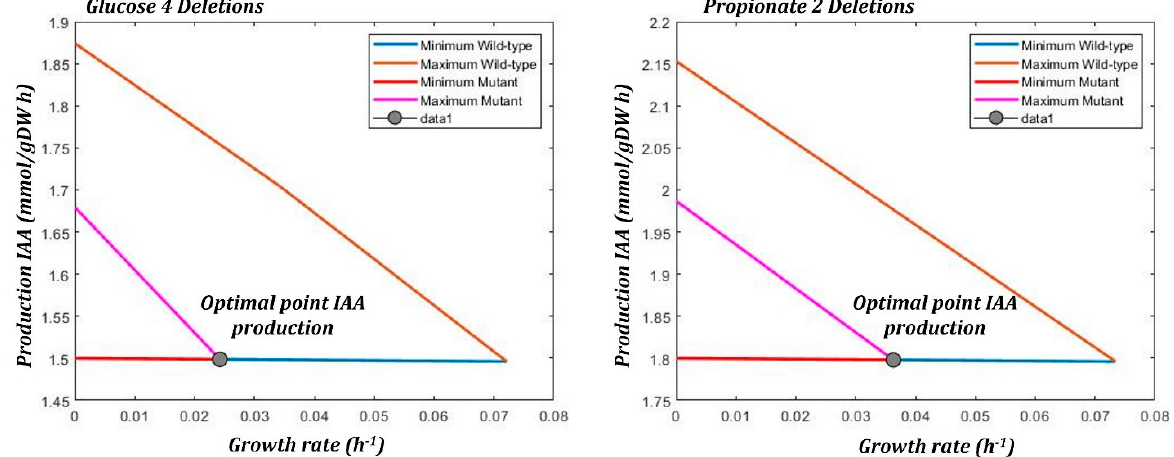
Figure 9. Graphs obtained from the simulation with OptKnock. The intersection point corresponds to the optimal solution.